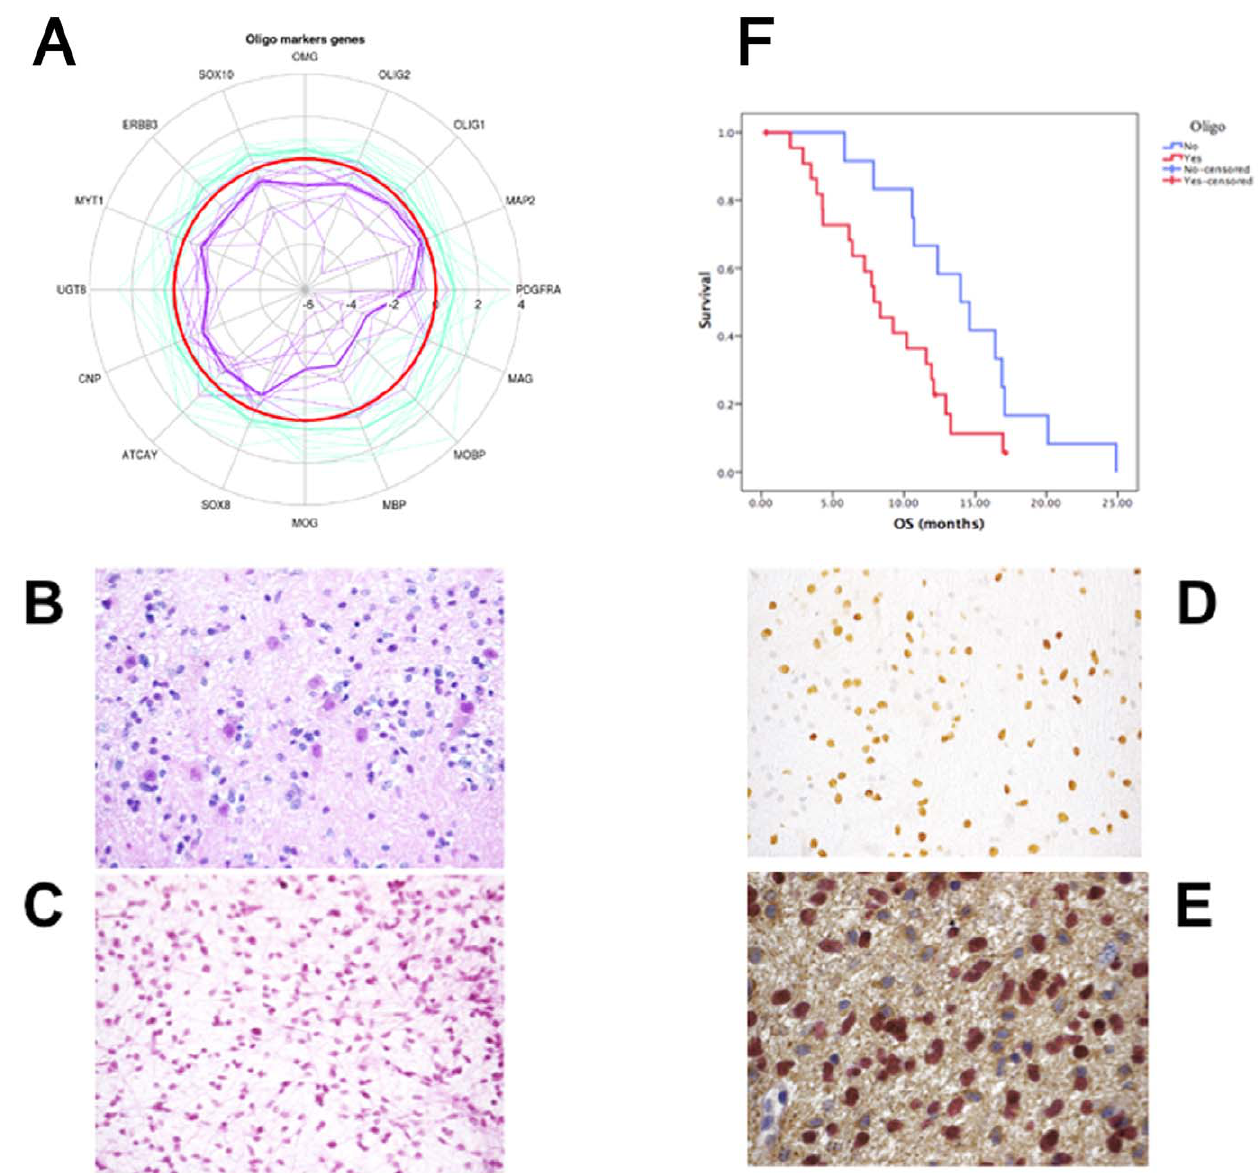
Figure 4. Description of the oligodendroglial/proneural type of DIPG. Panel A: Radial plot showing the expression of oligodendroglial markers in the two groups of DIPG, in log2 ratios related each other. The red circle represent the median expression level of the whole population of DIPG. Group 1 expresses higher levels of oligodendroglial markers than group 2 DIPG. Panel B: Morphological oligodendroglial differenciation in group 1 tumors (HES staining, 6 40). Panel C: Morphological astrocytic differenciation in group 2 tumors (HES staining 6 40). Panel D: Olig2 immunohistochemistry in a group 1 DIPG showing that probably not all cells in the biopsy are tumoral ( 6 40). Panel E: Dual immunohistochemistry for Olig2 and GFAP showing that tumor cells in mitosis are GFAP negative but Olig2 positive ( 6 100). Panel F: Overall survival of 55 DIPG according to the presence (red) or absence (blue) of oligodendroglial differenciation. Median OS was shorter in patients with oligodendroglial type of tumors (7.73 vs 12.37, p=0.045, log rank